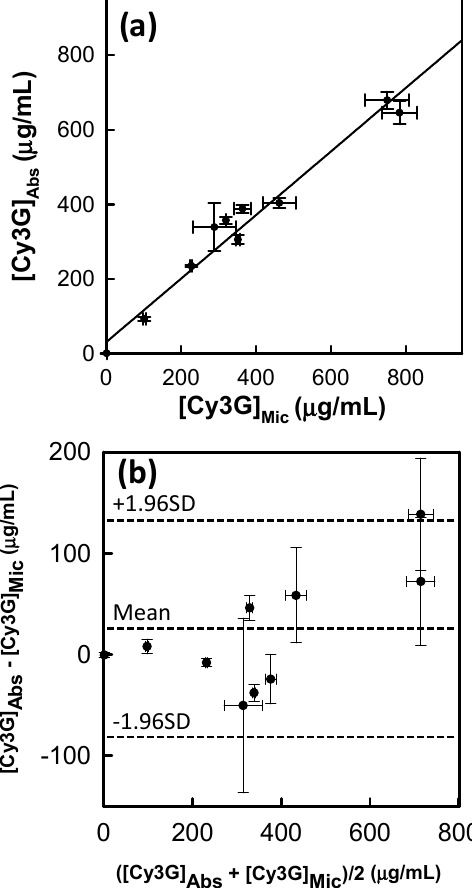
Figure 7. ( a ) Correlation between the concentration values measured via the mobile microchip and spectrophotometric method, denoted as [Cy3G] Abs and [Cy3G] Mic , respectively. ( b ) The Bland– Altman plot demonstrates the agreement between the two methods.